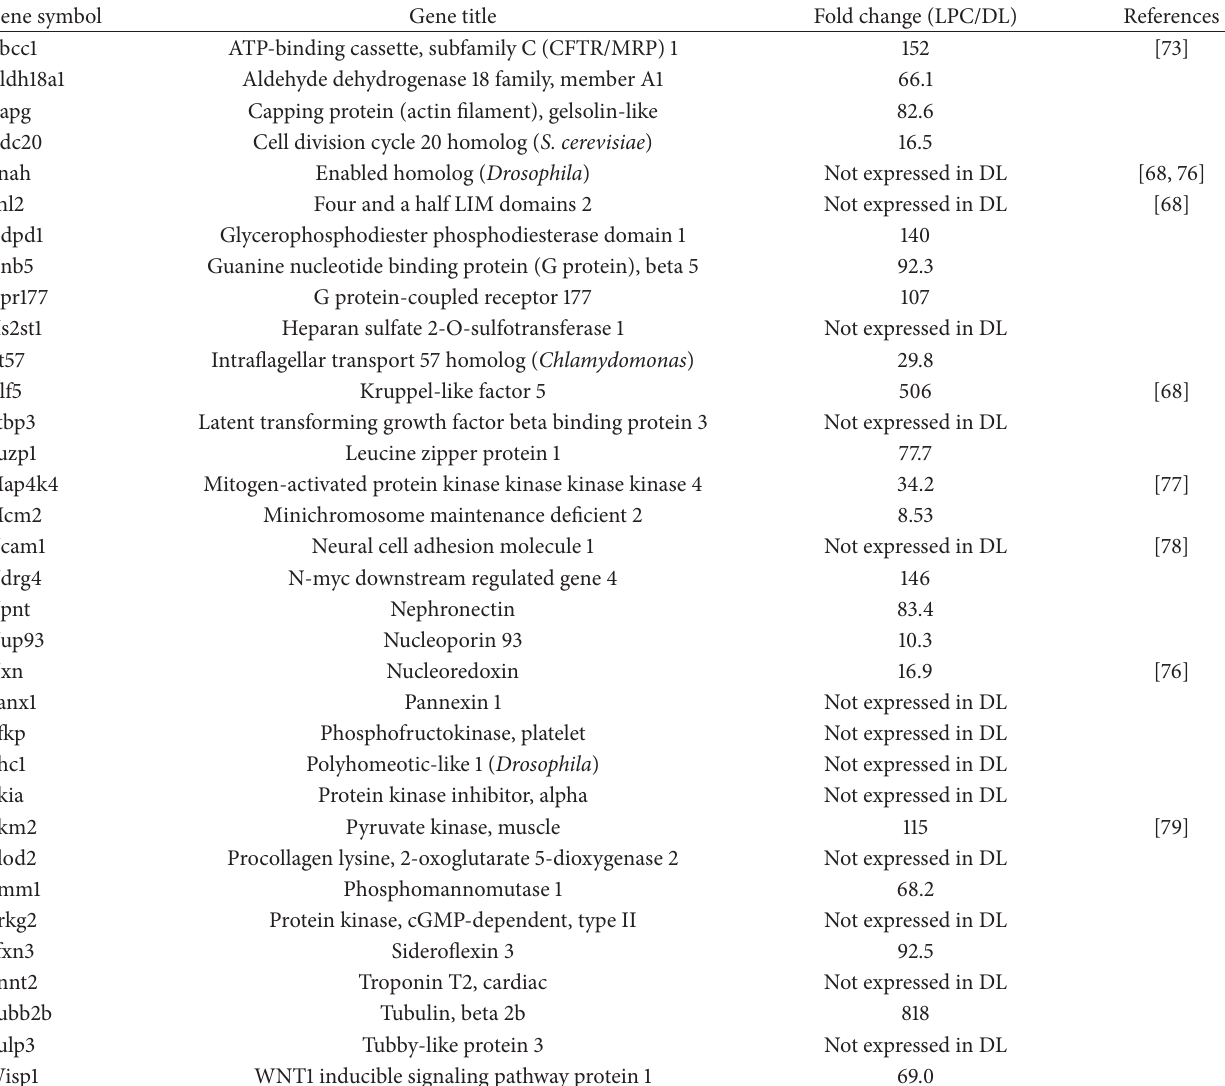
Table 1: Markers for liver progenitor cells (LPCs): expression profiles that correlate closely with known LPC markers were mined for potential marker genes. Gene symbol, title, and transcript abundance fold change in LPCs relative to developed liver (DL). References to studies that identified genes as LPC markers are included where